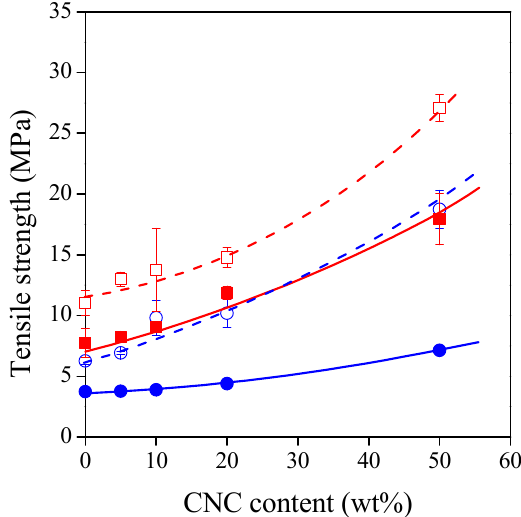
Figure 5. Tensile strength of TPS–CNC composites as a function of CNC content. Symbols: ( ) 30% glycerol; ( • ) 40% glycerol; ( (cid:3) ) 30% sorbitol; ( (cid:4) ) 40% sorbitol.